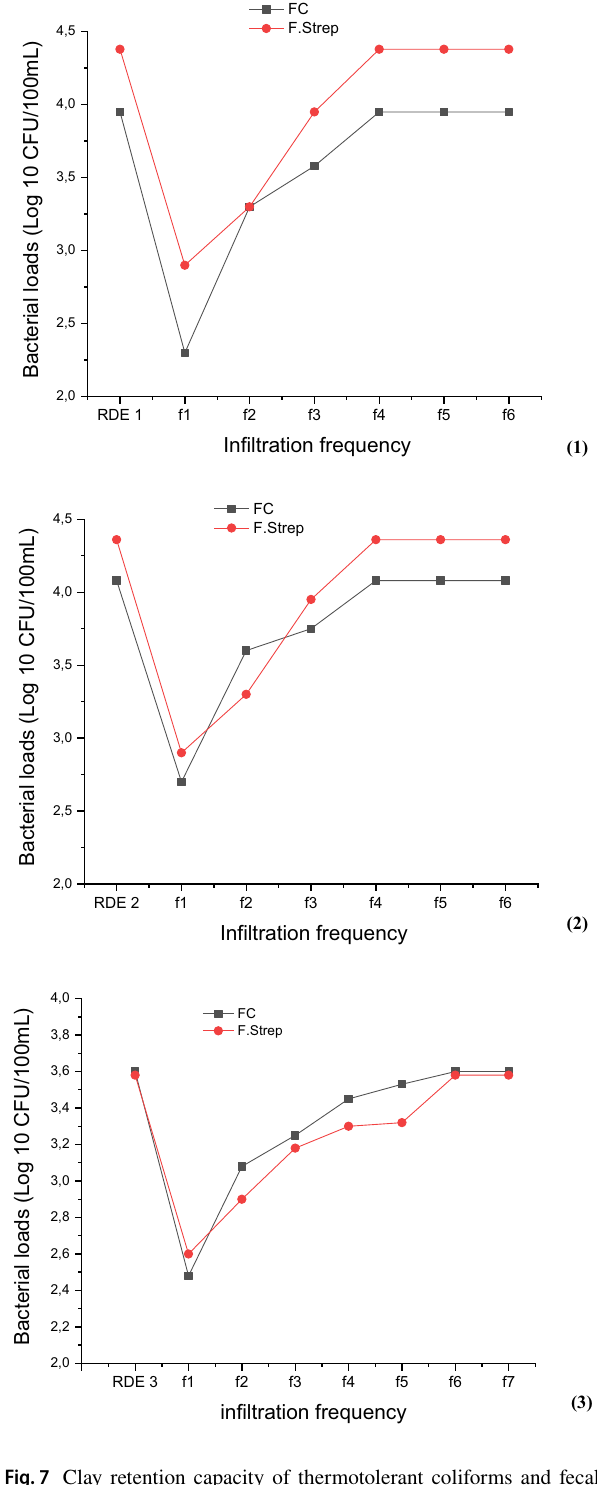
Fig. 7 Clay retention capacity of thermotolerant coliforms and fecal streptococci by filtration using clay fixed-bed system. (1): DE1 sam- ple; (2): DE 2 sample; (3): DE 3 sample; DE: Dairy effluents; RDE: Raw dairy effluents; f (1 to 7): Infiltration frequency; FC: Thermotol- erant coliforms; F.Strep : Fecal streptococci